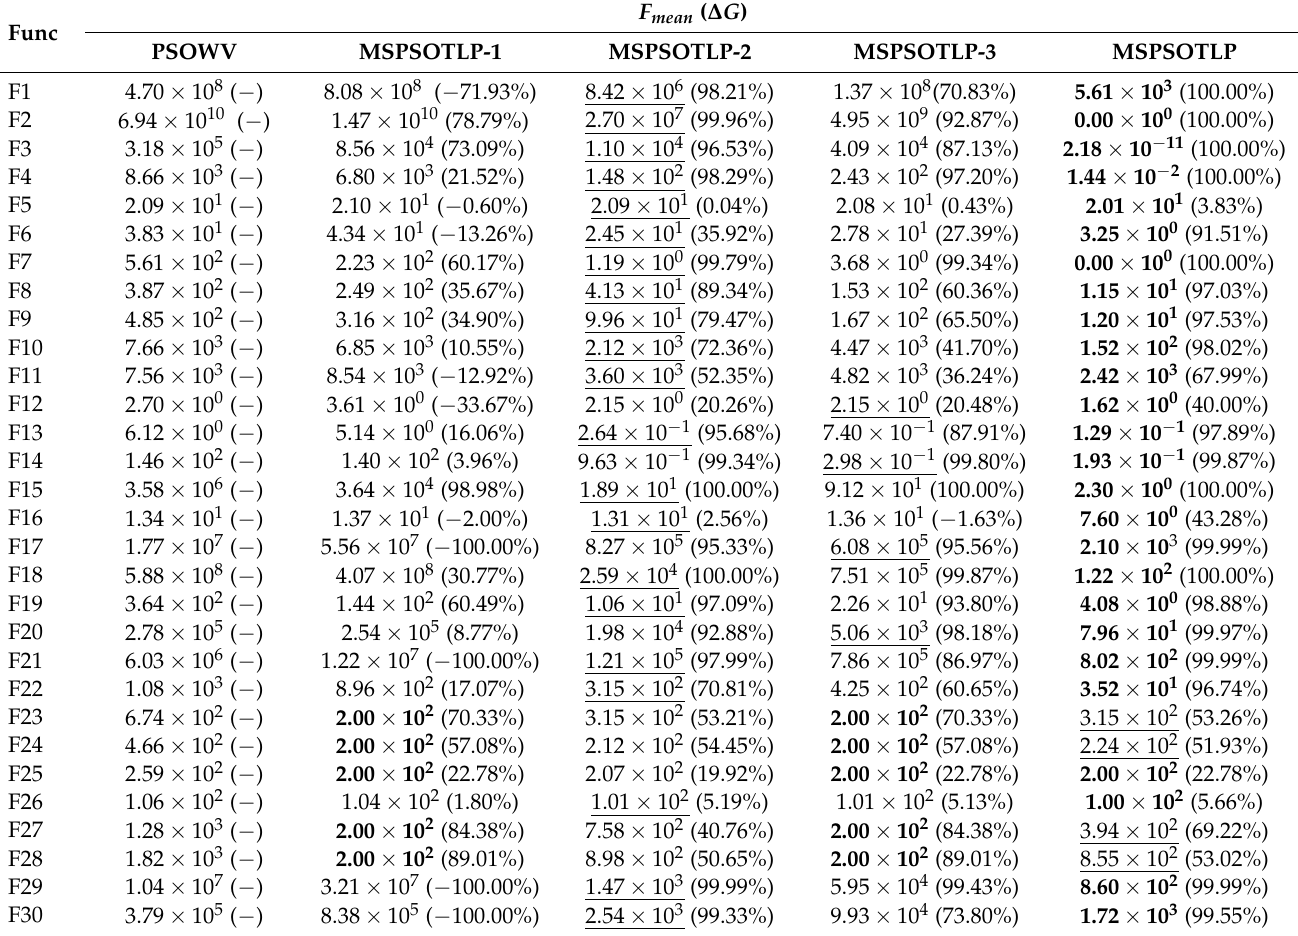
Table 9. Simulation results of F mean and ∆ P obtained by PSOWV and all MSPSOTLP variants when solving CEC 2014 benchmark